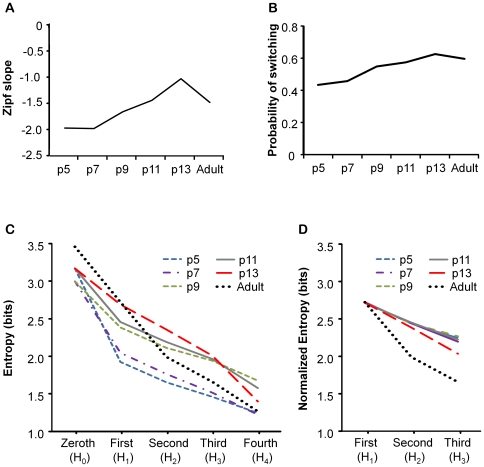
Change in the sequencing of syllables within bouts, across age.(A) The Zipf slopes increase with age, showing that the repertoire became less repetitious with increasing age. (B) The probability of a switch between syllables, in consecutive calls, increased with age. (C) For mice of different age groups, entropy declines as function of structural order. The negative slope indicates a higher-order structure in the syllable sequences at each age. (D) Slopes of the first to third order entropies, normalized to the value for adults for graphical purposes only. Note that the negative slope is steeper for p13 pups than for the younger pups, indicating greater higher-order structure within song bouts. P13 animals had significantly more sequential structure than younger animals. Adults had significantly more sequential structure than pups at any age.